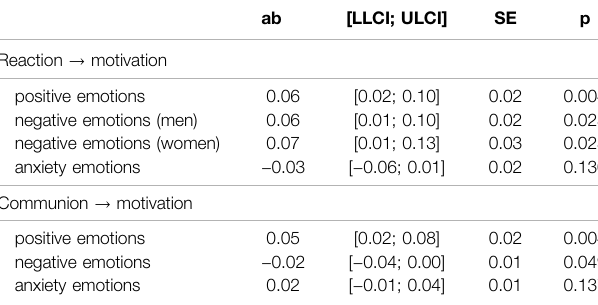
TABLE 5 | Indirect effects in modi fi ed path